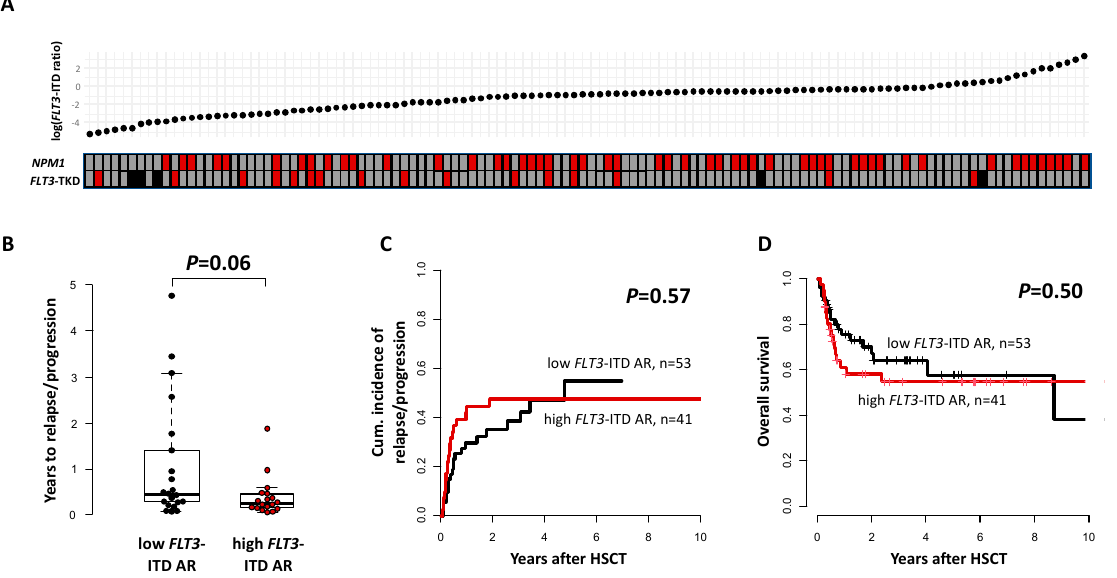
Figure 2. Associations and Outcome according to FLT3 -ITD allelic ratio (AR, high vs. low, 0.5 cuts, n = 94). ( A ) Association between FLT3 -ITD allelic ratio and NPM1 as well as FLT3 -TKD mutation status. Grey: wild-type, red: mutated, black: missing information. ( B ) Time to relapse in relapsing patients, ( C ) Cumulative incidence of relapse/progression, and ( D ) Overall survival.